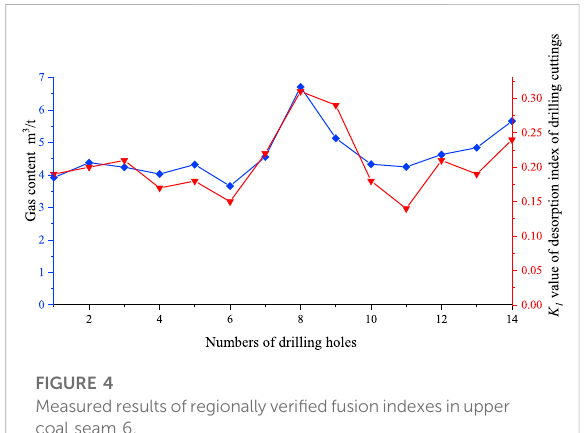
FIGURE 4 Measuredresultsofregionallyveri fi